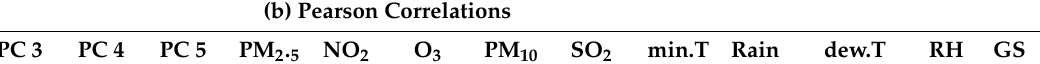
(b) Pearson Correlations